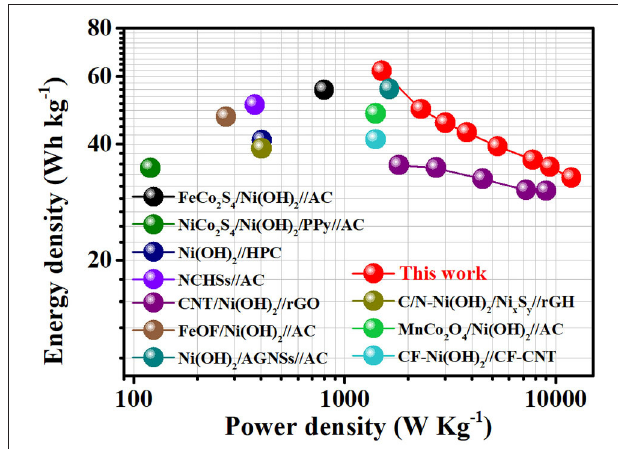
FIGURE 5 | Power densities and energy densities of the AFSC devices in comparison with the state-of-the-art reported supercapacitors based on Ni(OH) 2